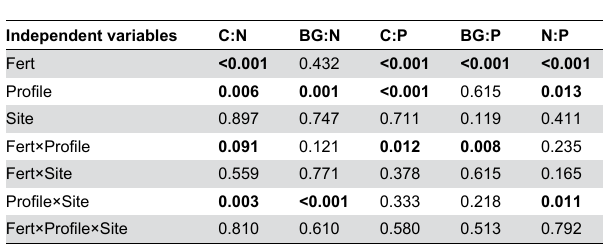
Table 3. Summary of p -values resulting from mixed-effect model analyses for stoichiometry assayed at 15°C.